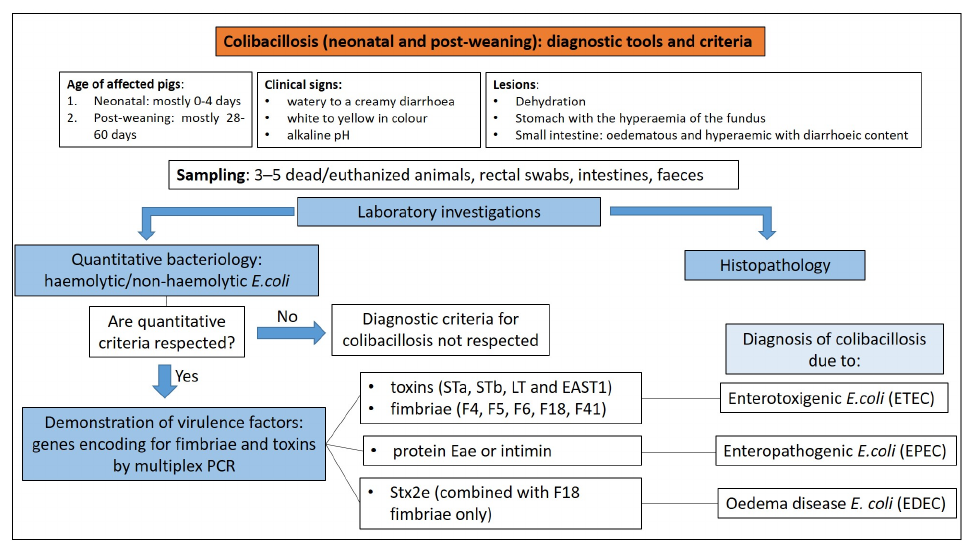
Figure 10. Diagnostic algorithm for the diagnosis of